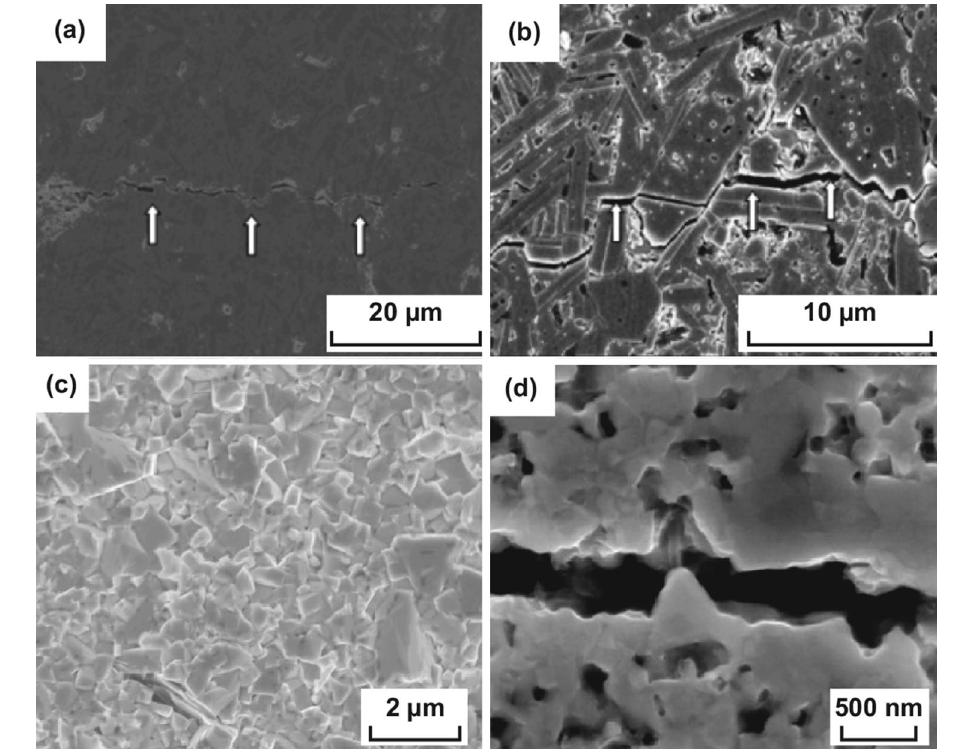
Fig. 14 FE‑SEM micrographs of crack propagation in a WC–5 vol% CNT and b WC–10 vol% CNT [161]. Typical SEM images of c the frac‑ ture surfaces and d crack details of WC–CNT composites [166]. Figure panels reproduced from Ref. [161] with permission from INST